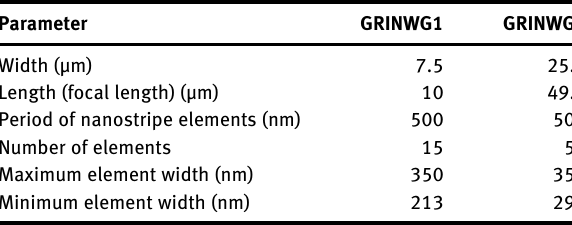
Table  : Key parameters for the